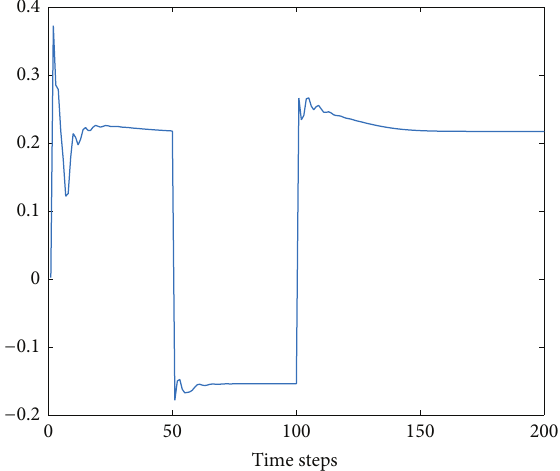
Figure 8: Control input 𝑢 of jumping-parameters system with multiple ADP